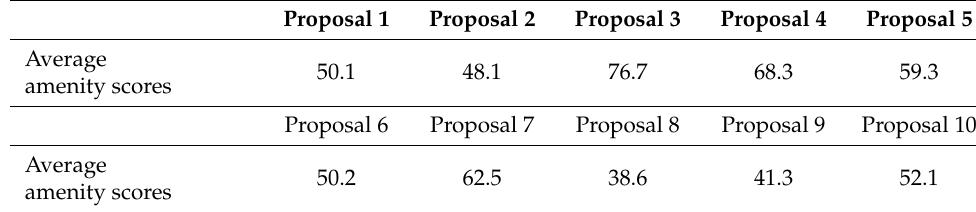
Table 5. Average amenity scores of 10 representative urban design proposals.